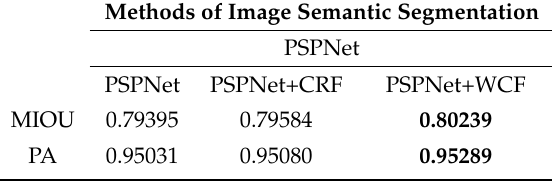
Table 2. Comparison with enhancement results of